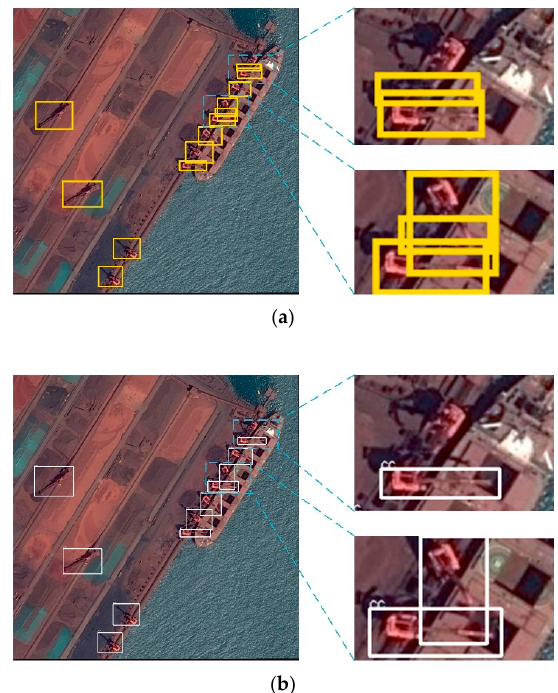
Figure 9. Visual contrast: ( a ) detection result. ( b ) ground truth.